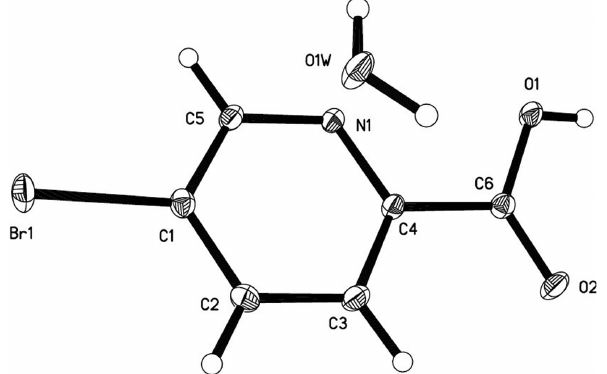
Table 2: Fractional atomic coordinates and isotropic or